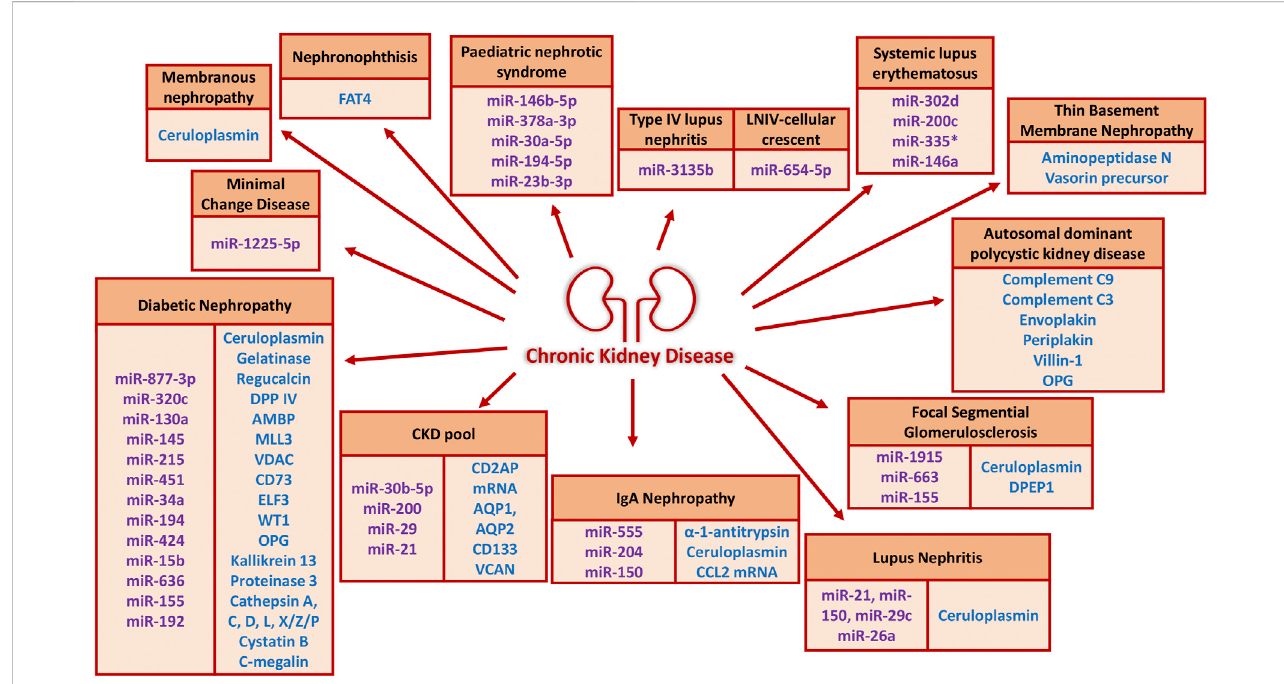
FIGURE 3 uEVs proteins and miRNAs of potential diagnostic and prognostic value in the literature (since 2012) grouped according to CKD etiologies. The protein cargo is shown in blue and the miRNA cargo in